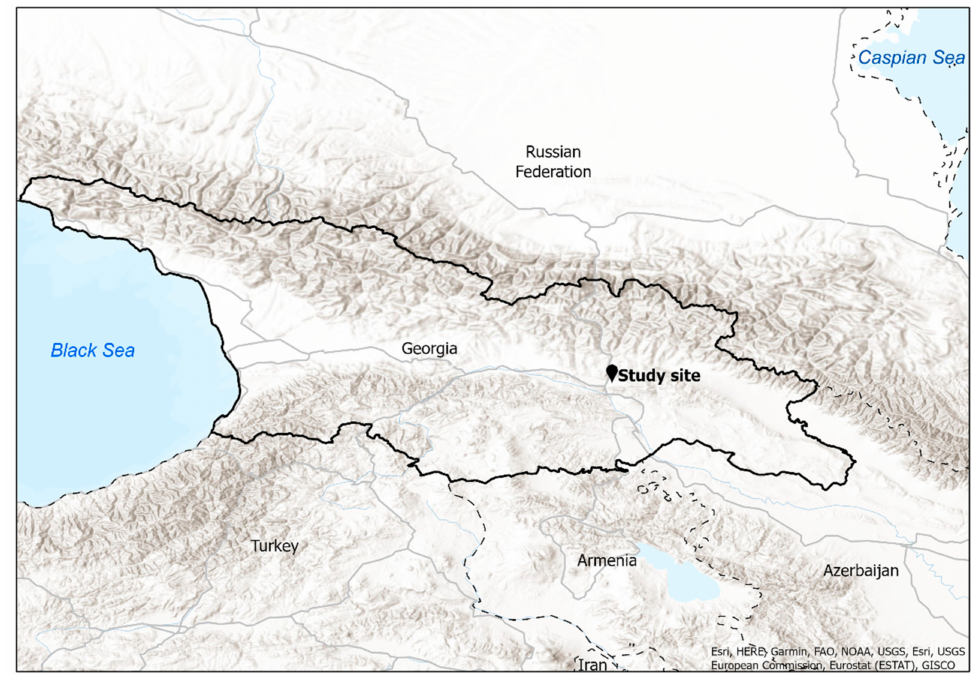
Figure 1. The location of the study site in Georgia (41 ◦ 55 (cid:48) 01.75 N 44 ◦ 46 (cid:48) 18.37 E, 586 m